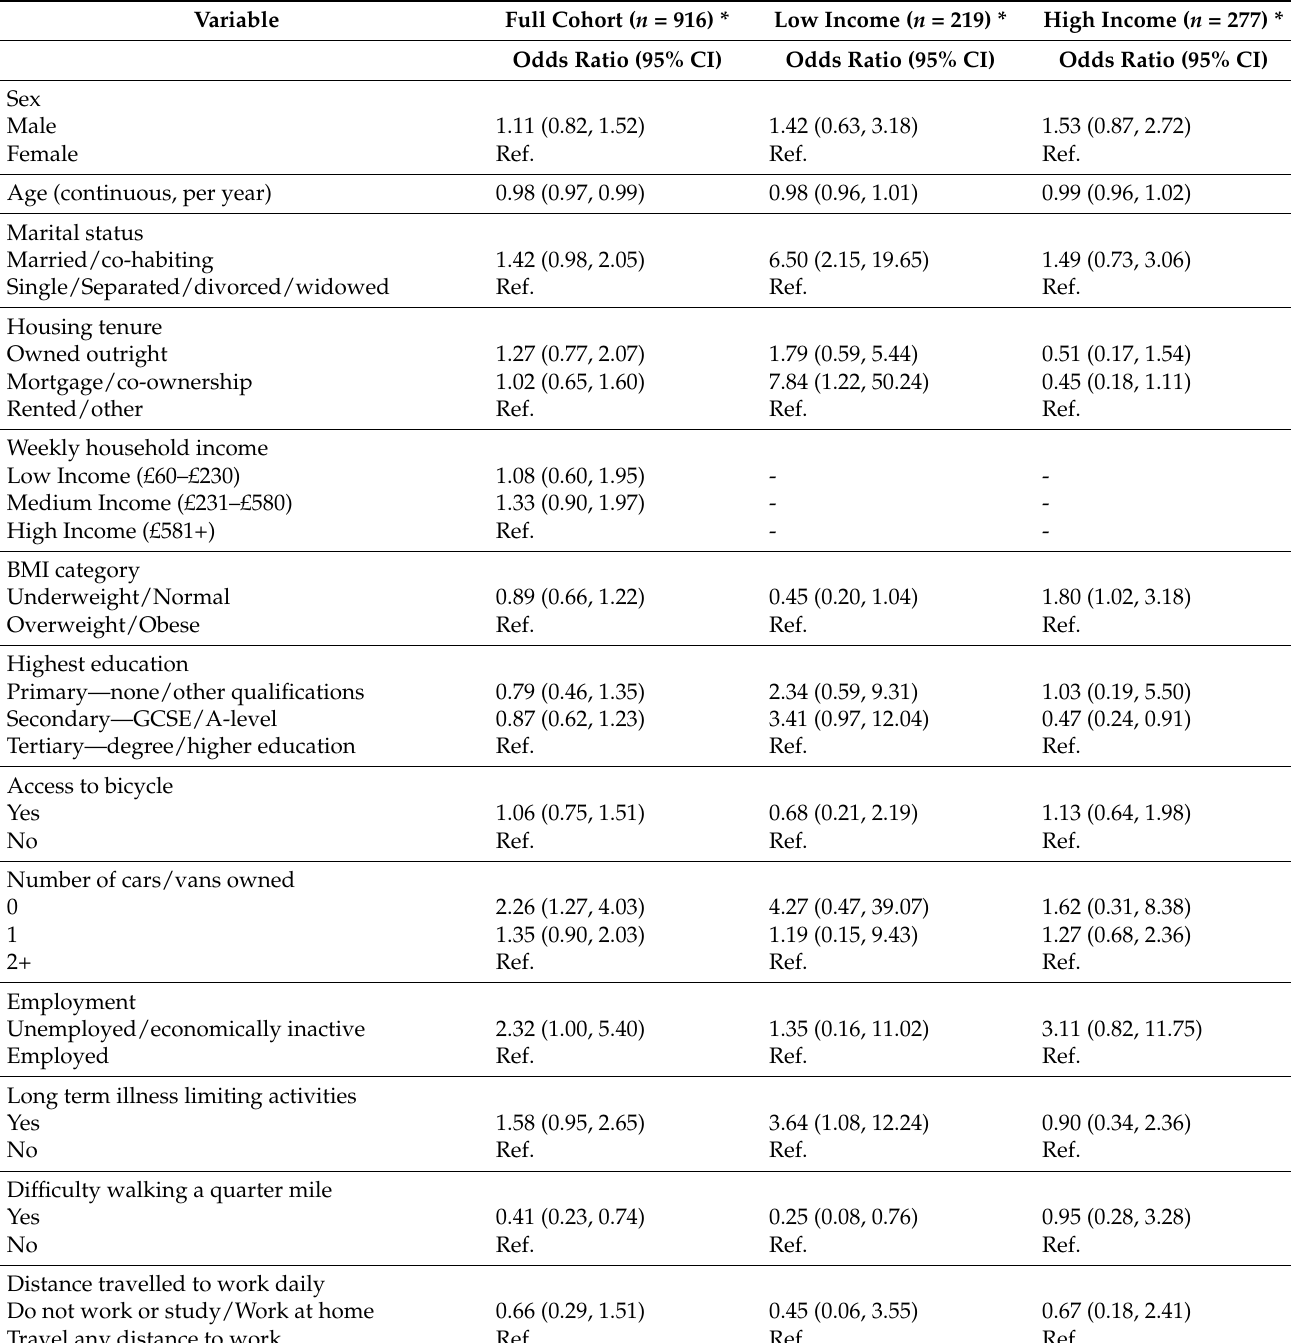
Table 5. Multiple logistic regression of socio-demographic, health, environmental and psychological associations of those engaging in 150 min plus of active travel for full cohort and by low and high